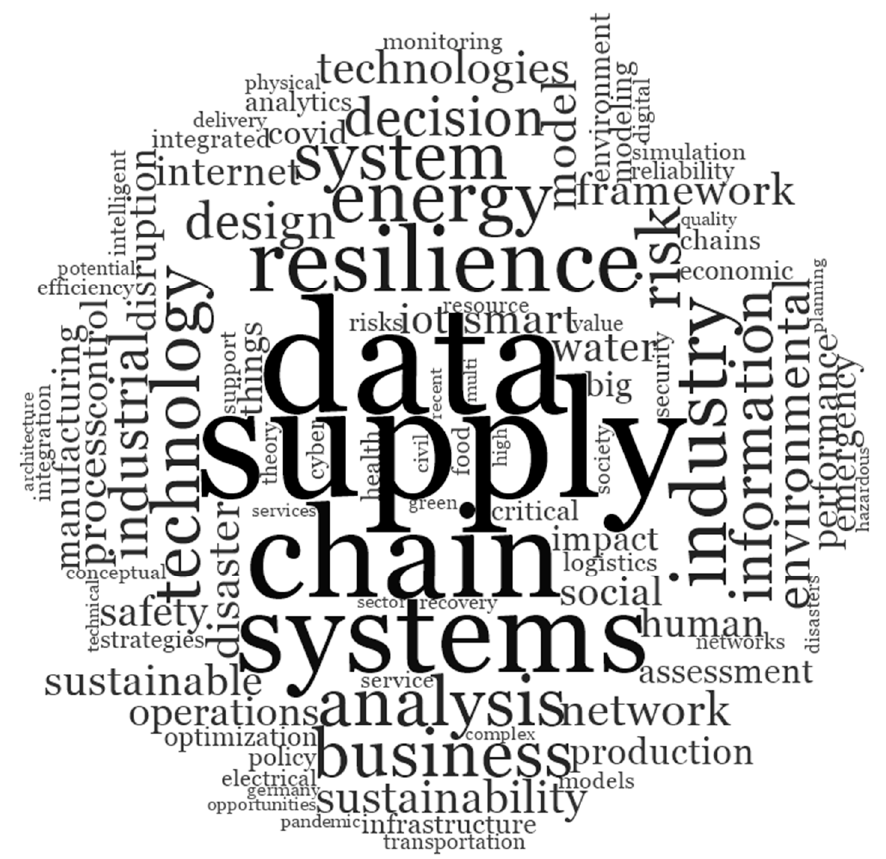
Figure 8. Word clouds of the preliminary clusters based on 144 retrieved articles.